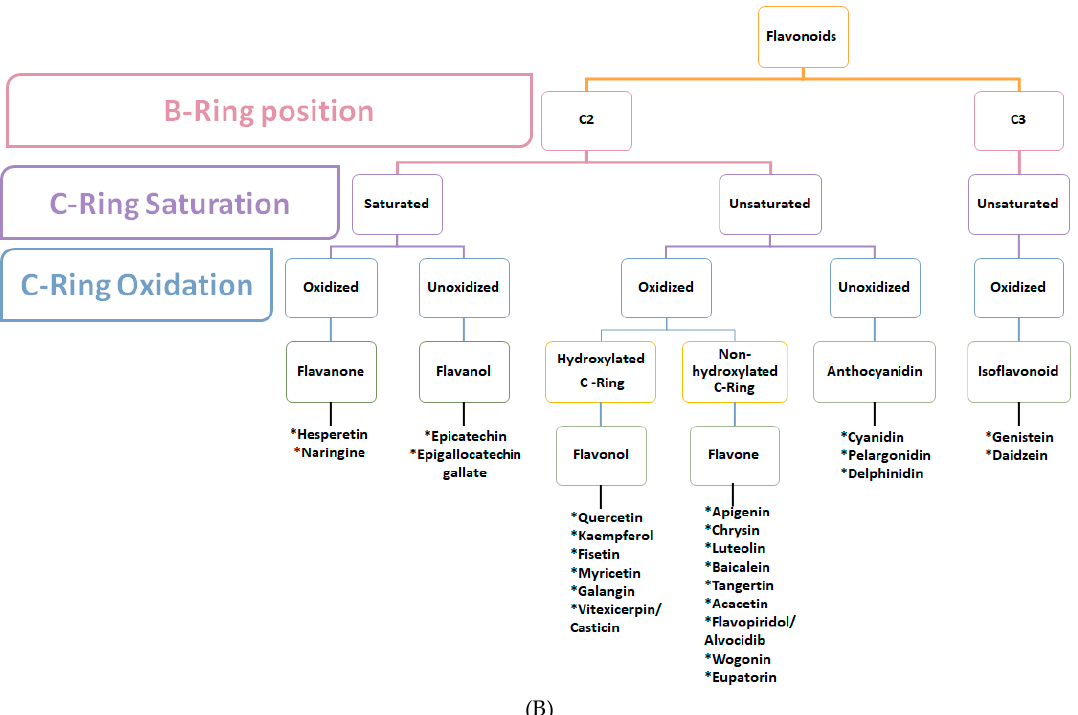
Figure 5. ( A ) Classification of flavonoids into six classes depending on structural differences: flavonol, flavanone, flavanol, flavone, anthocyanidin, and isoflavonoid. ( B ) Structural classification of plant flavonoids according to the position of B-ring on C2 or C3, B-ring saturation and oxidation.